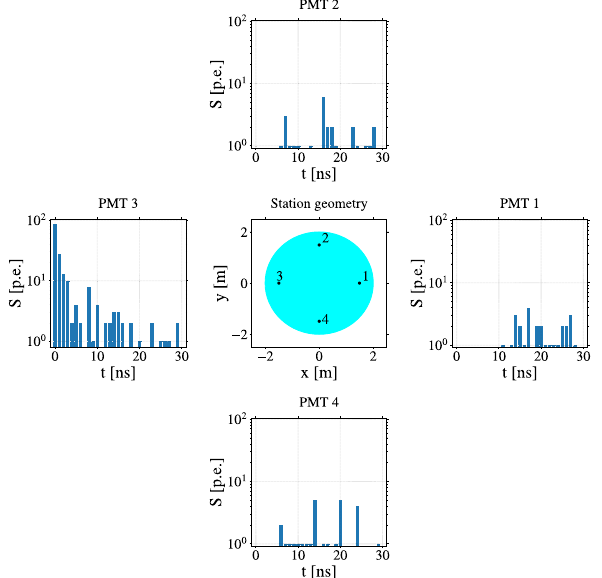
Fig. 2 Single-layered WCD crossed by a single relativistic muon. The WCD drawing is surrounded by the correspondent PMT signal time